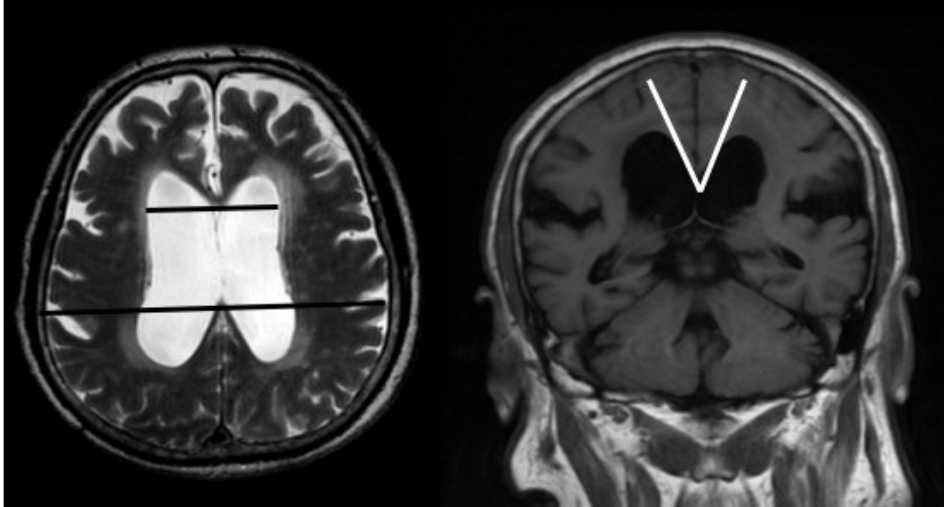
Figure 1. Pre-operative brain MRI (magnetic resonance imaging) of one representative patient with iNPH (idiopathic normal pressure hydrocephalus), who showed an increased Evans’ index (>0.3) and a sharp callosal angle (<90 